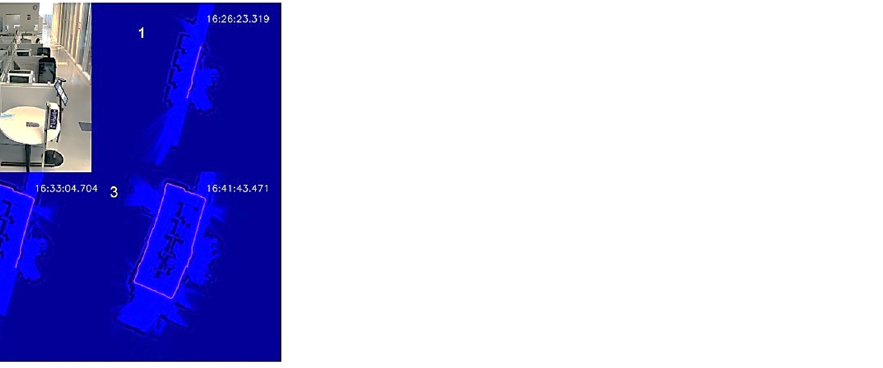
Figure 11. UVBot disinfection test in a corridor. (1–3) Progression of the UVBot in this environment.